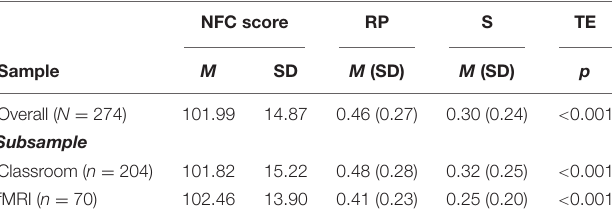
TABLE 1 | Descriptive statistics related to the testing effect, NFC scores for the different